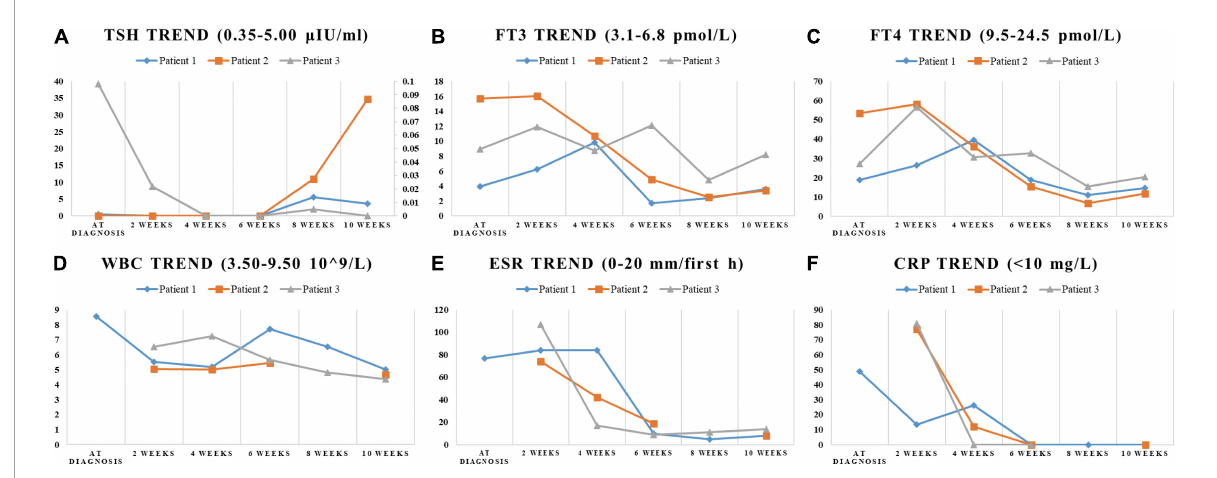
FIGURE2 The trend of indicators in laboratory tests. The change of TSH, FT3, FT4, WBC, ESR, and CRP during the SAT period were displayed in (A–F) . (A) The ordinate axis on the right side is used only for patient 3 due to the large numerical span.